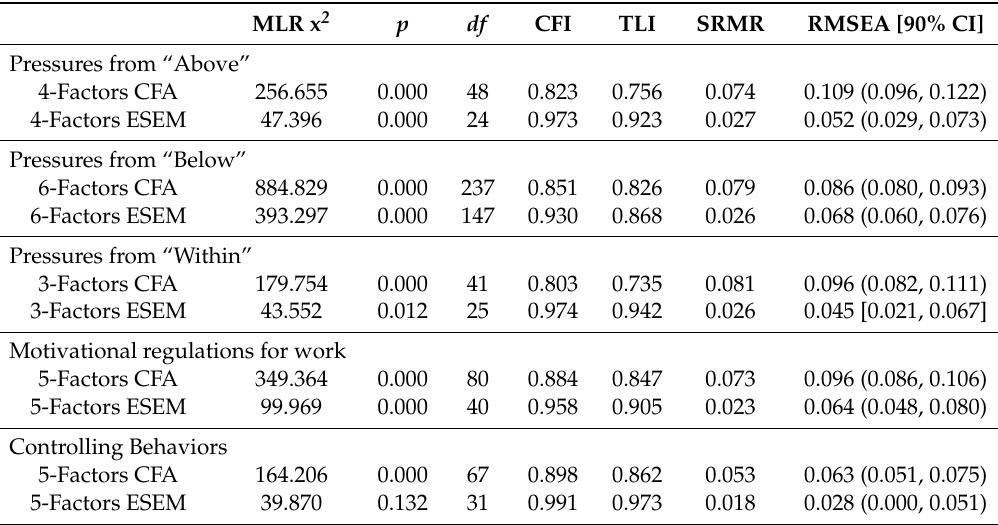
Table A1. Measurement